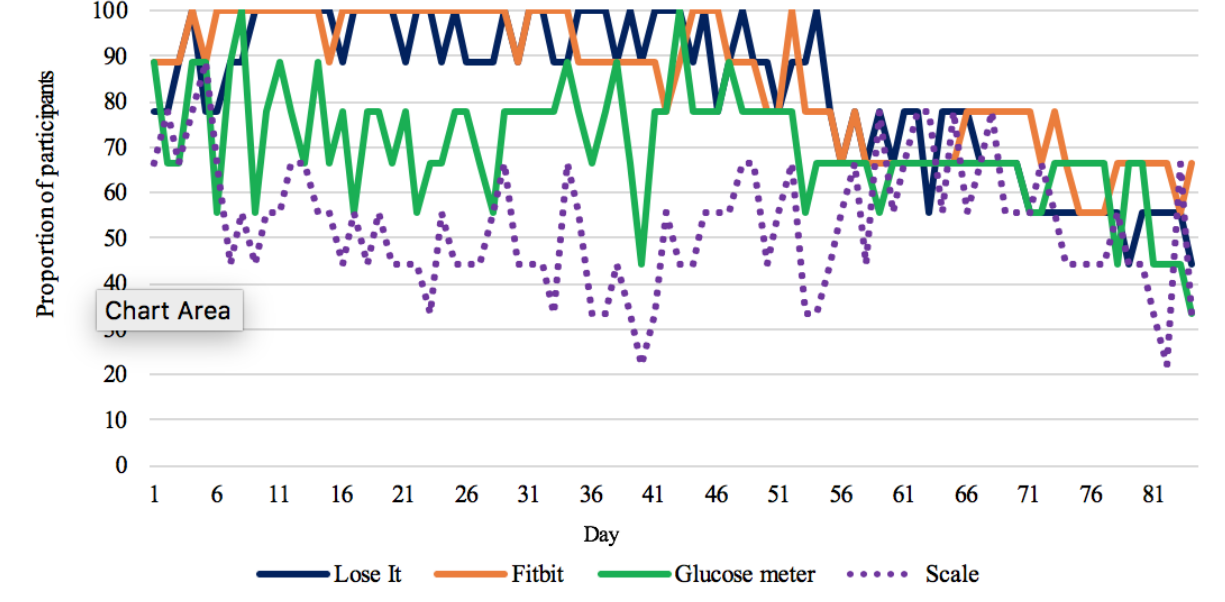
Figure 3. Proportion of participants using the self-monitoring device and app by day of monitoring.